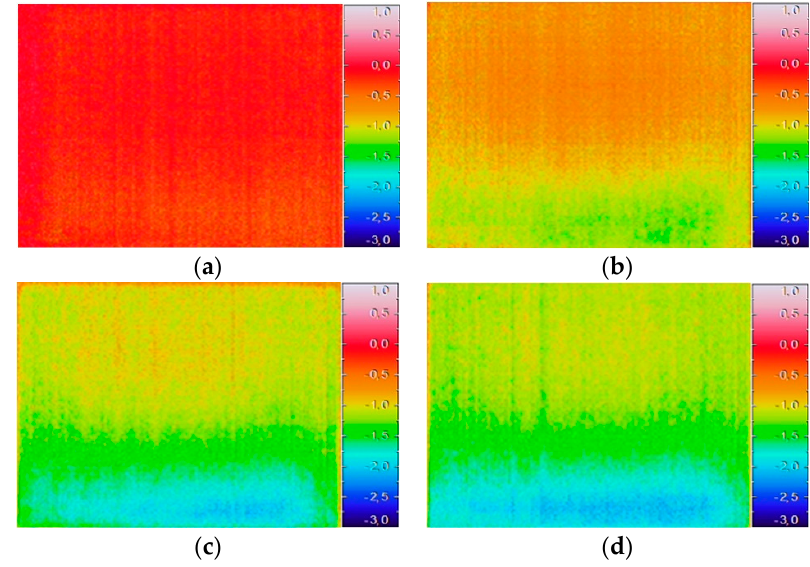
Figure 10. Image subtraction considering, as a reference, the first thermal image taken immediately after the humidification period began: ( a ) t = 0.5 h; ( b ) t = 2.5 h; ( c ) t = 9 h; ( d ) t = 24 h. Sensors 2018 , 18 , x FOR PEER REVIEW